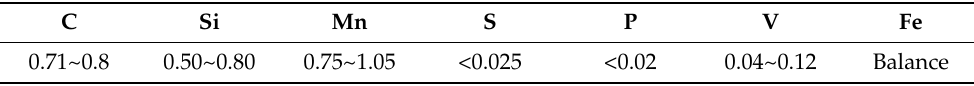
Table 1. Chemical composition of U75V rail steel (wt. %).